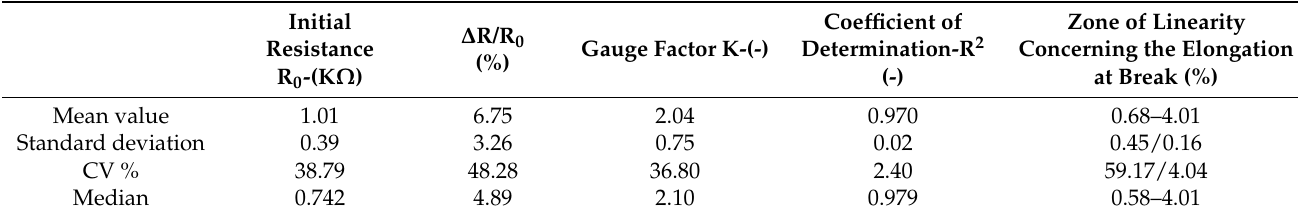
Table 3. Statistical results of the electromechanical behaviour of sensor yarns with 8 layers of piezoresistive coating.